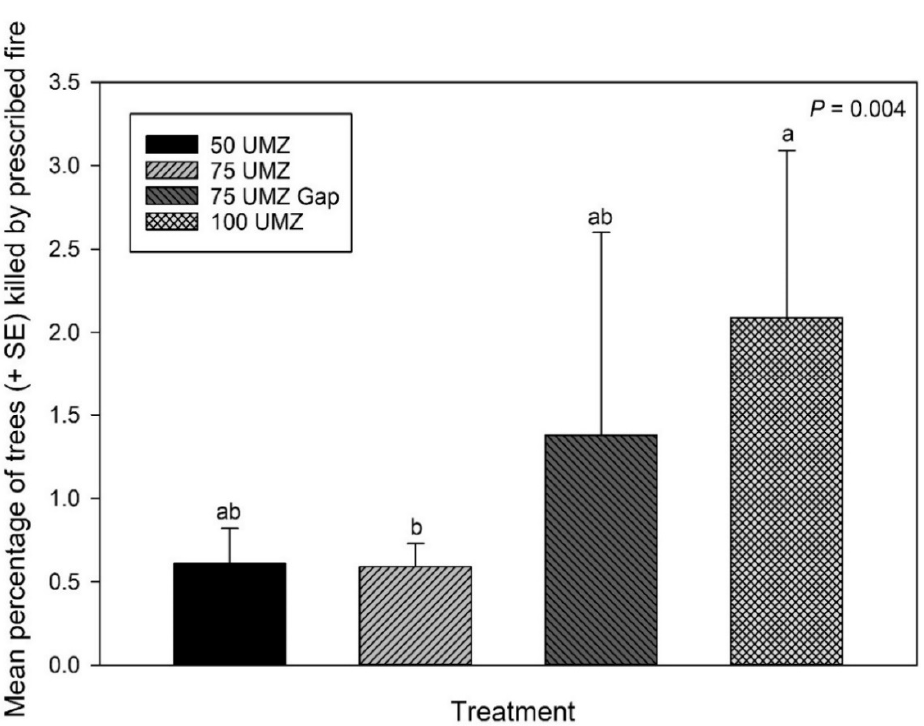
Figure 2. Mean percentage (+SE) of trees killed by prescribed fire following thinning and prescribed burning at Pringle Falls Experimental Forest, Oregon. Means (+SE) followed by the same letter are not significantly different ( p > 0.05).